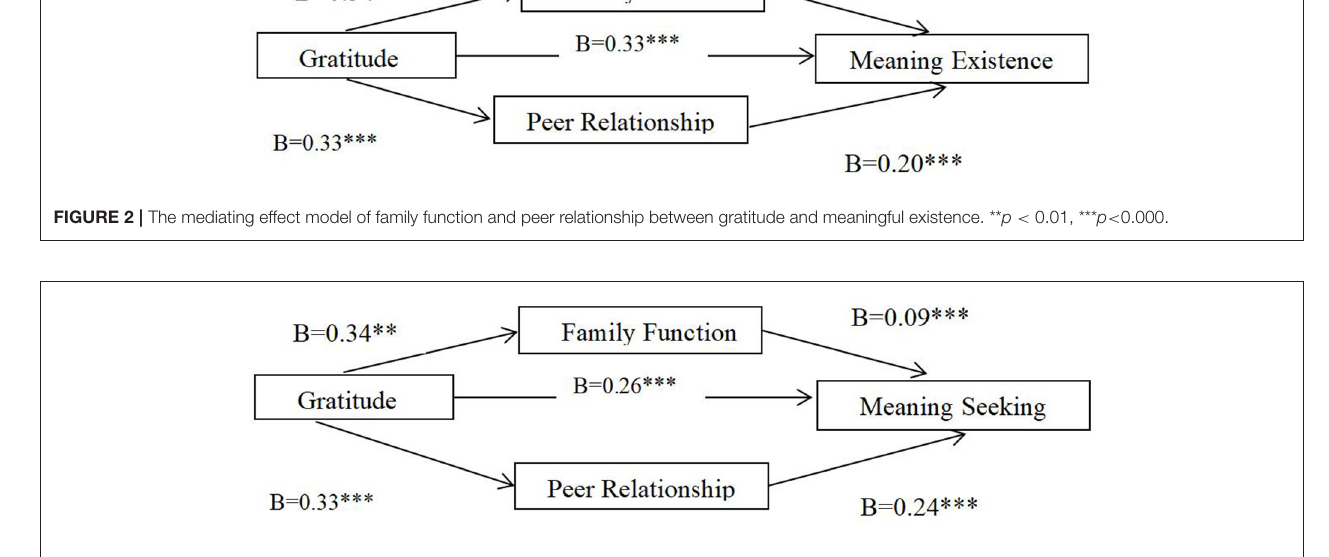
FIGURE 3 | The mediating effect model of family function and peer relationship between gratitude and meaningful seeking. ** p < 0.01, *** p <